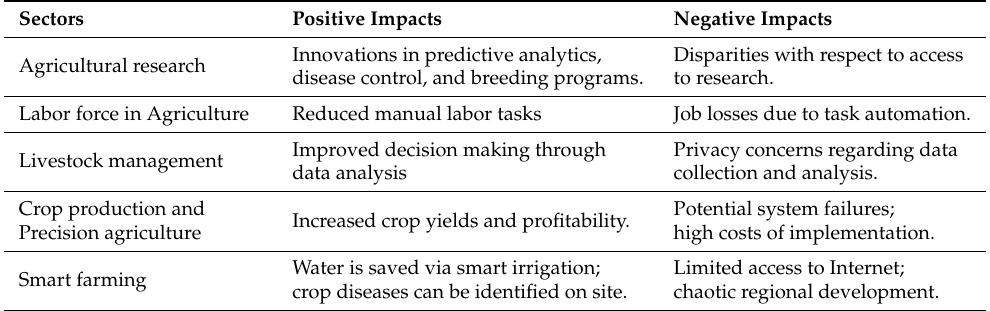
Table 9. AI’s positive and negative disruptive impacts on agriculture. Sectors Positive Impacts Negative Impacts Innovations in predictive analytics, Agricultural research disease control, and breeding programs. Labor force in Agriculture Reduced manual labor tasks Job losses due to task automation. Improved decision making through Livestock management data analysis